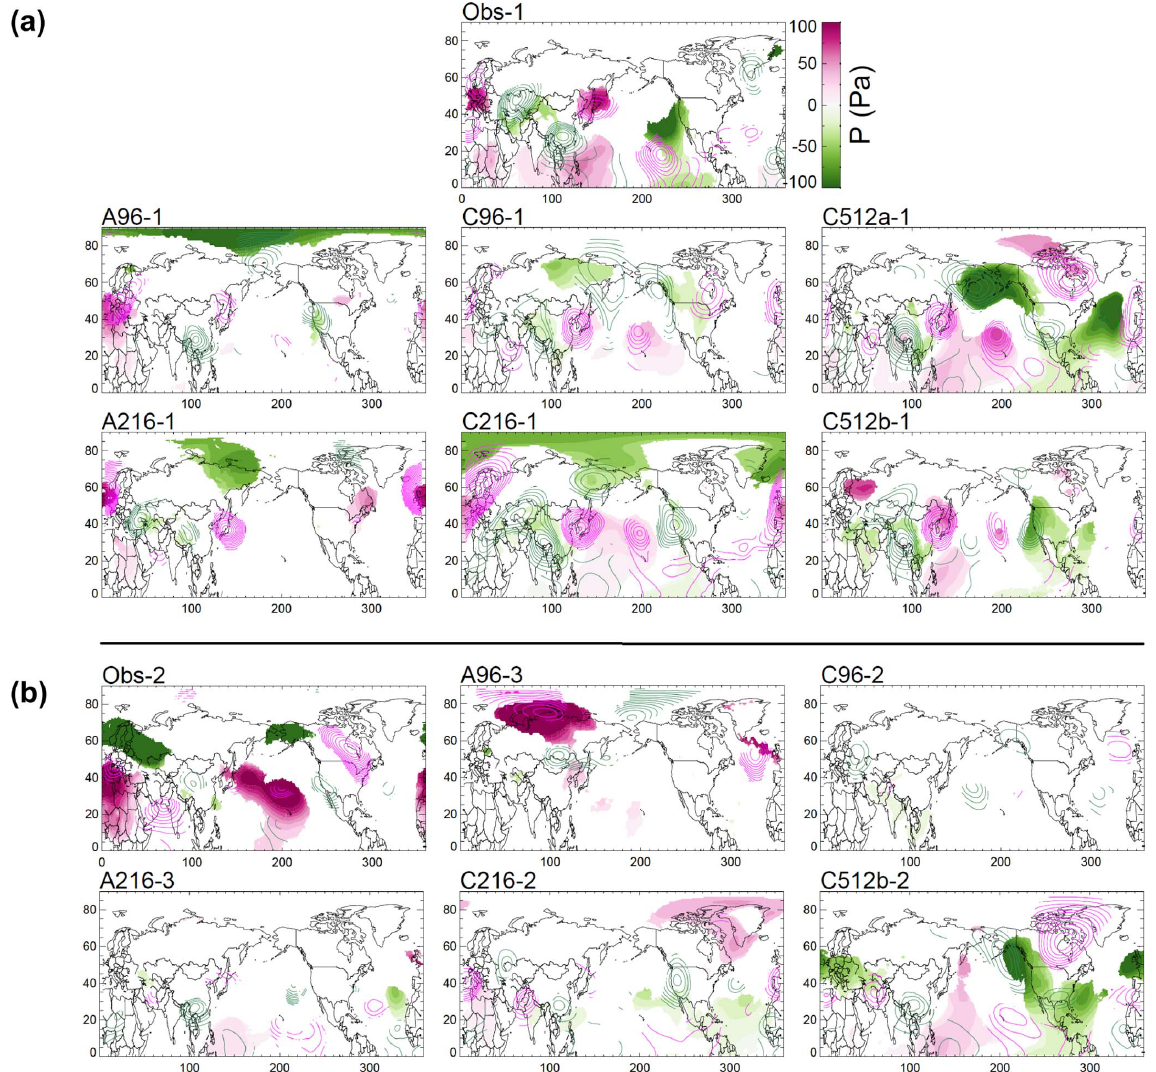
Figure 7. Regressions of P SFC (shading) and Z 200 (contours at intervals of 0.02m; pink – positive; green – negative) against normalised DJF EOT time series. Panel (a) is for EOTs matching the first observed pattern and (b) for the second observed pattern. All shown values are significant at the 90% confidence